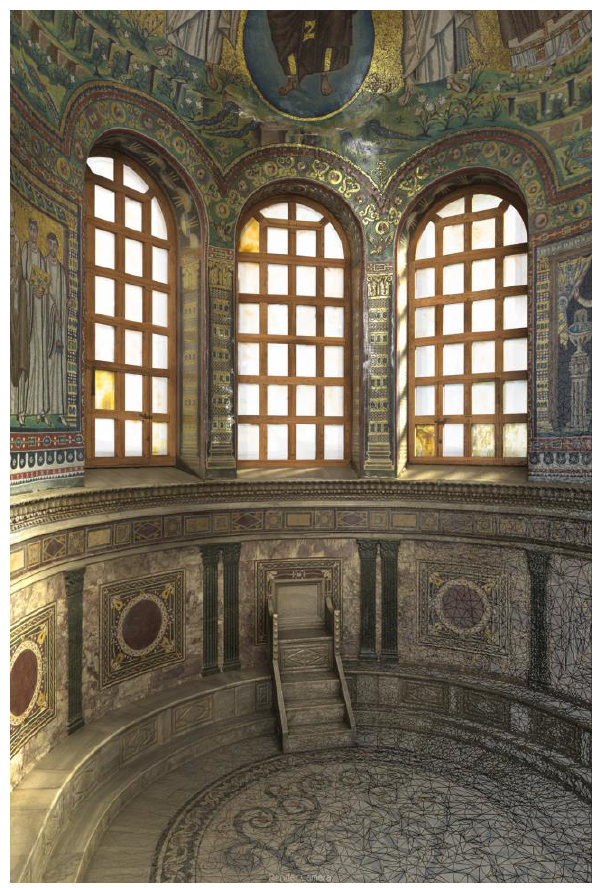
Figure 17. Rendering of San Vitale’s